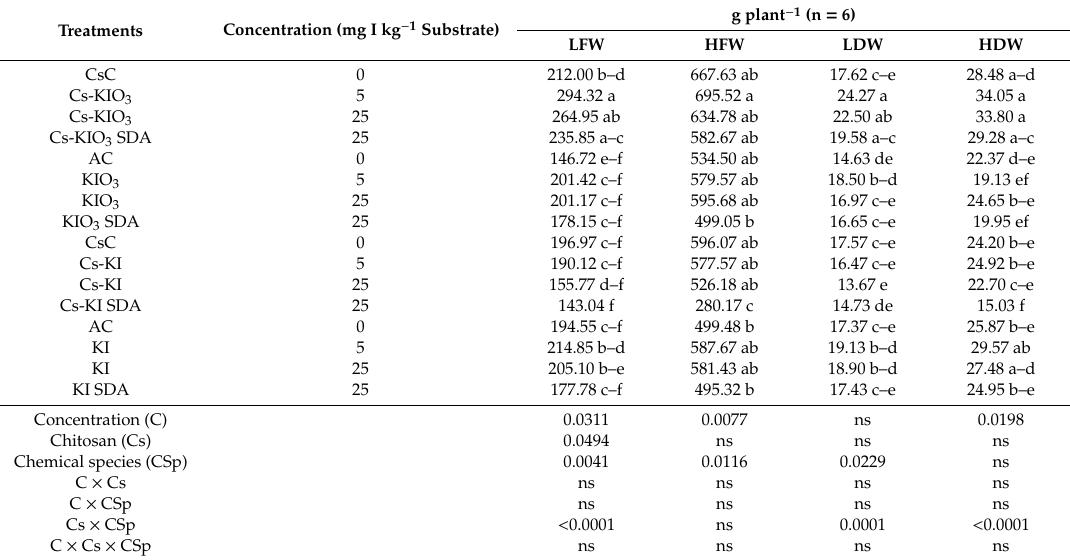
Table 1. Comparison of lettuce biomass